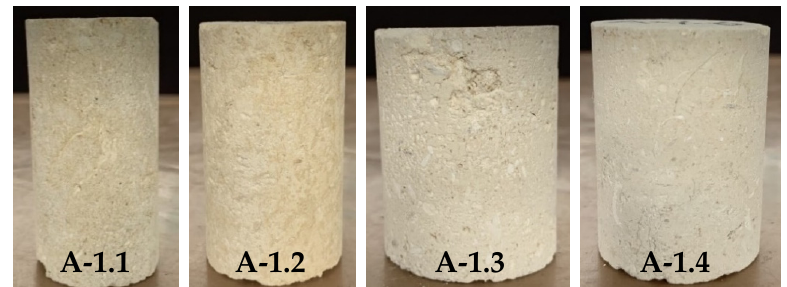
Figure 1. PETRONS-1 core plug samples.